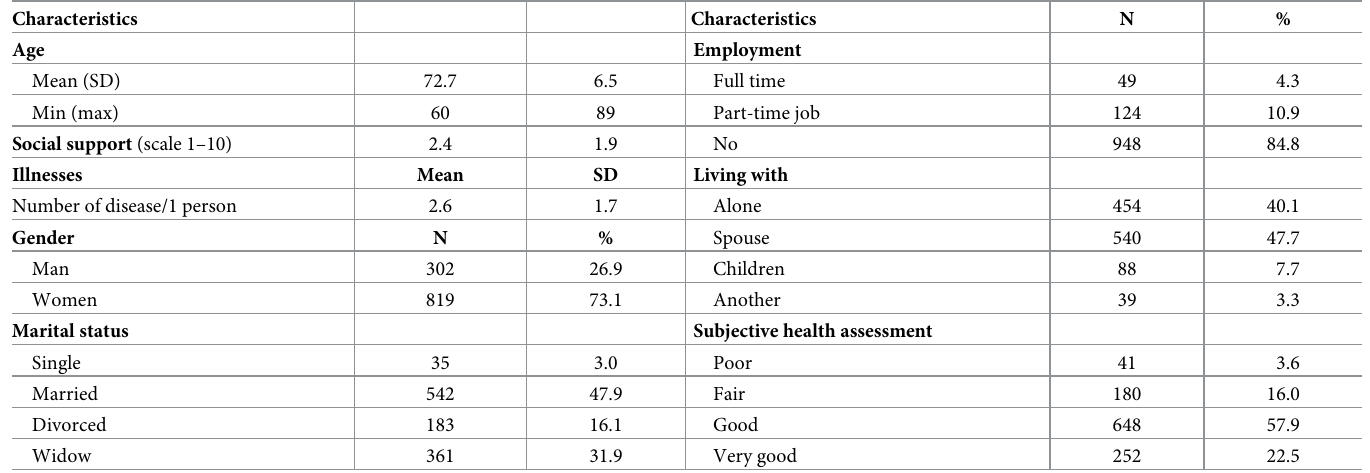
Table 1. Socio-demographic and health characteristics of sample (n = 1 121).